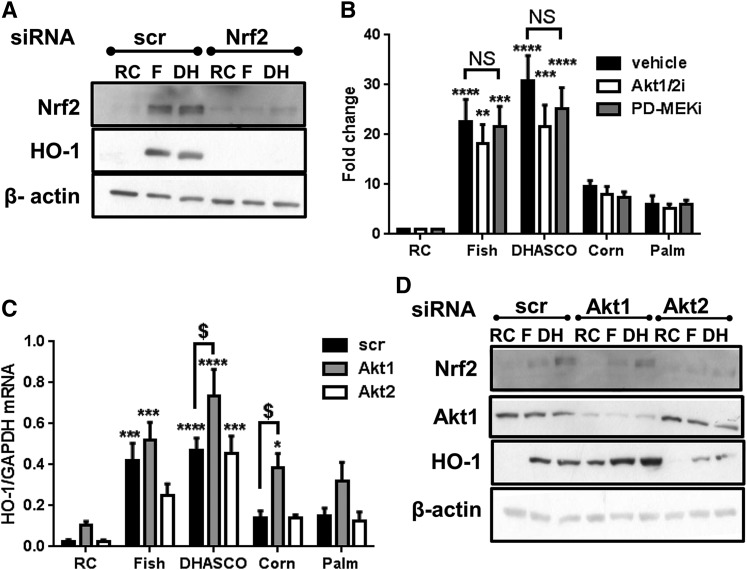
HO-1 induction by A-CRLPs is Nrf2 dependent but independent of Akt and ERK. A: HAECs transfected with 20 nM noncoding (scr) or Nrf2 siRNA were incubated with remnant control (RC), fish (F), or DHASCO® (DH) A-CRLPs (280 μM TG) for 7 h. Representative blots from three independent experiments are shown. B: Serum-starved HAECs were preincubated with DMSO (vehicle), 1 μM Akt1/2i, or 1 μM PD184352 (PD-MEKi) for 1 h then incubated with A-CRLPs for 4 h in the continued presence or absence of inhibitor. HO-1 mRNA expression normalized to GAPDH is presented as fold change relative to RC (mean ± SEM, n = 3). Two-way ANOVA with Bonferroni’s multiple comparisons test, vehicle versus inhibitors not significant (NS). RC versus A-CRLP indicated: **P < 0.01, ***P < 0.001, ****P < 0.0001. C, D: HAECs transfected with 20 nM noncoding (scr), Akt1, or Akt2 siRNA were serum starved then incubated with A-CRLPs for 4 h. C: HO-1 mRNA normalized to GAPDH (fold change relative to RC; mean ± SEM, n = 4). Two-way ANOVA with Bonferroni’s multiple comparisons test, scr versus Akt1 siRNA: $P < 0.05. RC versus CRLP: *P < 0.05, ***P < 0.001, ****P < 0.0001. D: Representative Western blots from four independent experiments are shown for Nrf2, Akt1, HO-1, and β-actin.